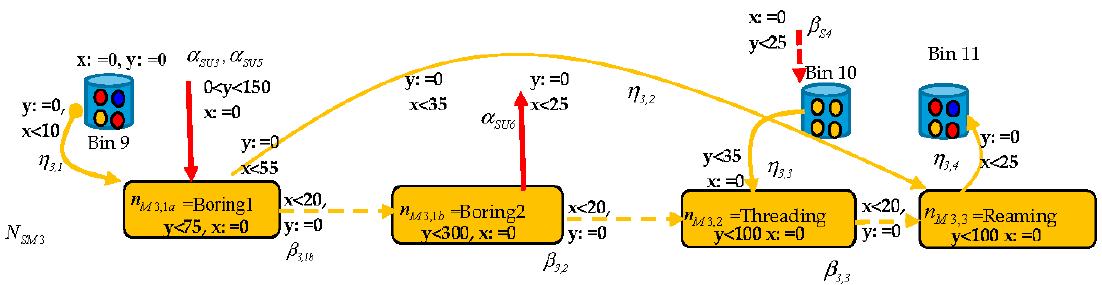
Figure 11. Interface Model of User #2 .